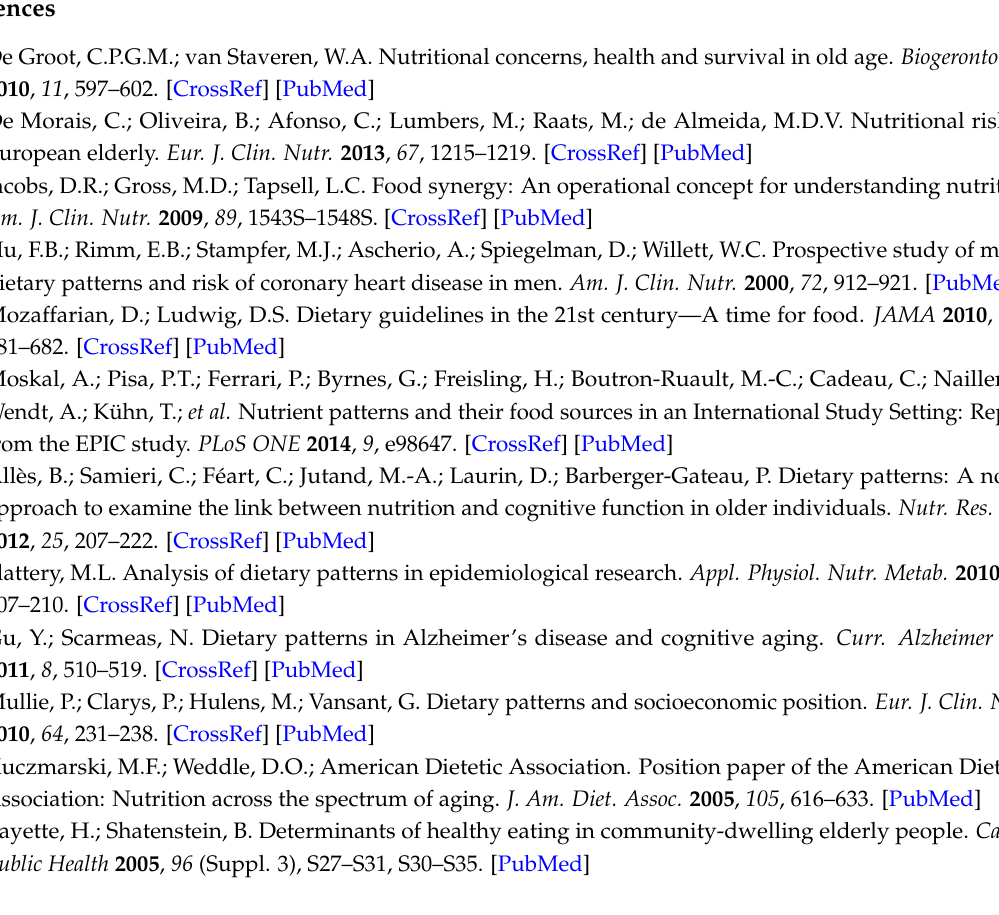
Table S1: Mean daily nutrient intakes according to quartiles of component scores obtained by factor analysis—principal component analysis of nutrient intake data in 3C ( n = 1712) from 24-h recall, Table S2: Mean daily nutrient intakes according to quartiles of component scores obtained by factor analysis—principal component analysis of nutrient intake data in NuAge ( n = 1596) from first 24-h